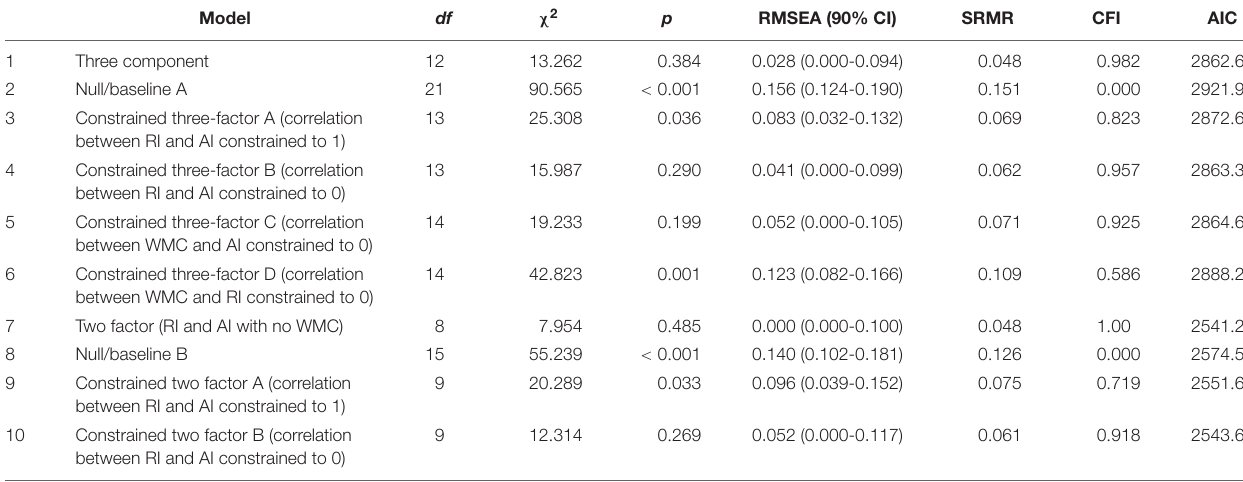
TABLE 6 | Summary of fit statistics for the competing confirmatory factor analysis